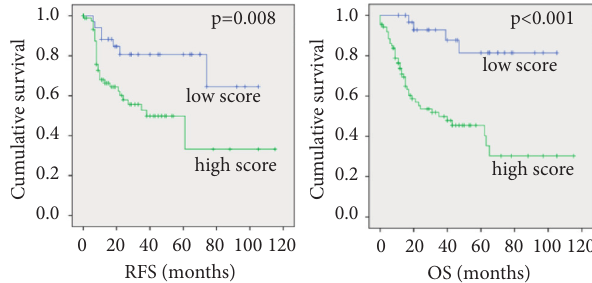
Figure 3: Evaluation of the prognostic performance of a score combining p16 and tobacco/alcohol habits in OSCC patients. Patients with a low score (p16+, no tobacco, no alcohol, n � 36) have a significantly longer RFS (HR: 3.1, 95% CI: 1.3–7.0) as well as a better OS (HR: 6.6, 95% CI: 2.3–18.4) than patients with a high score (p16 − , tobacco, alcohol, n � 87).